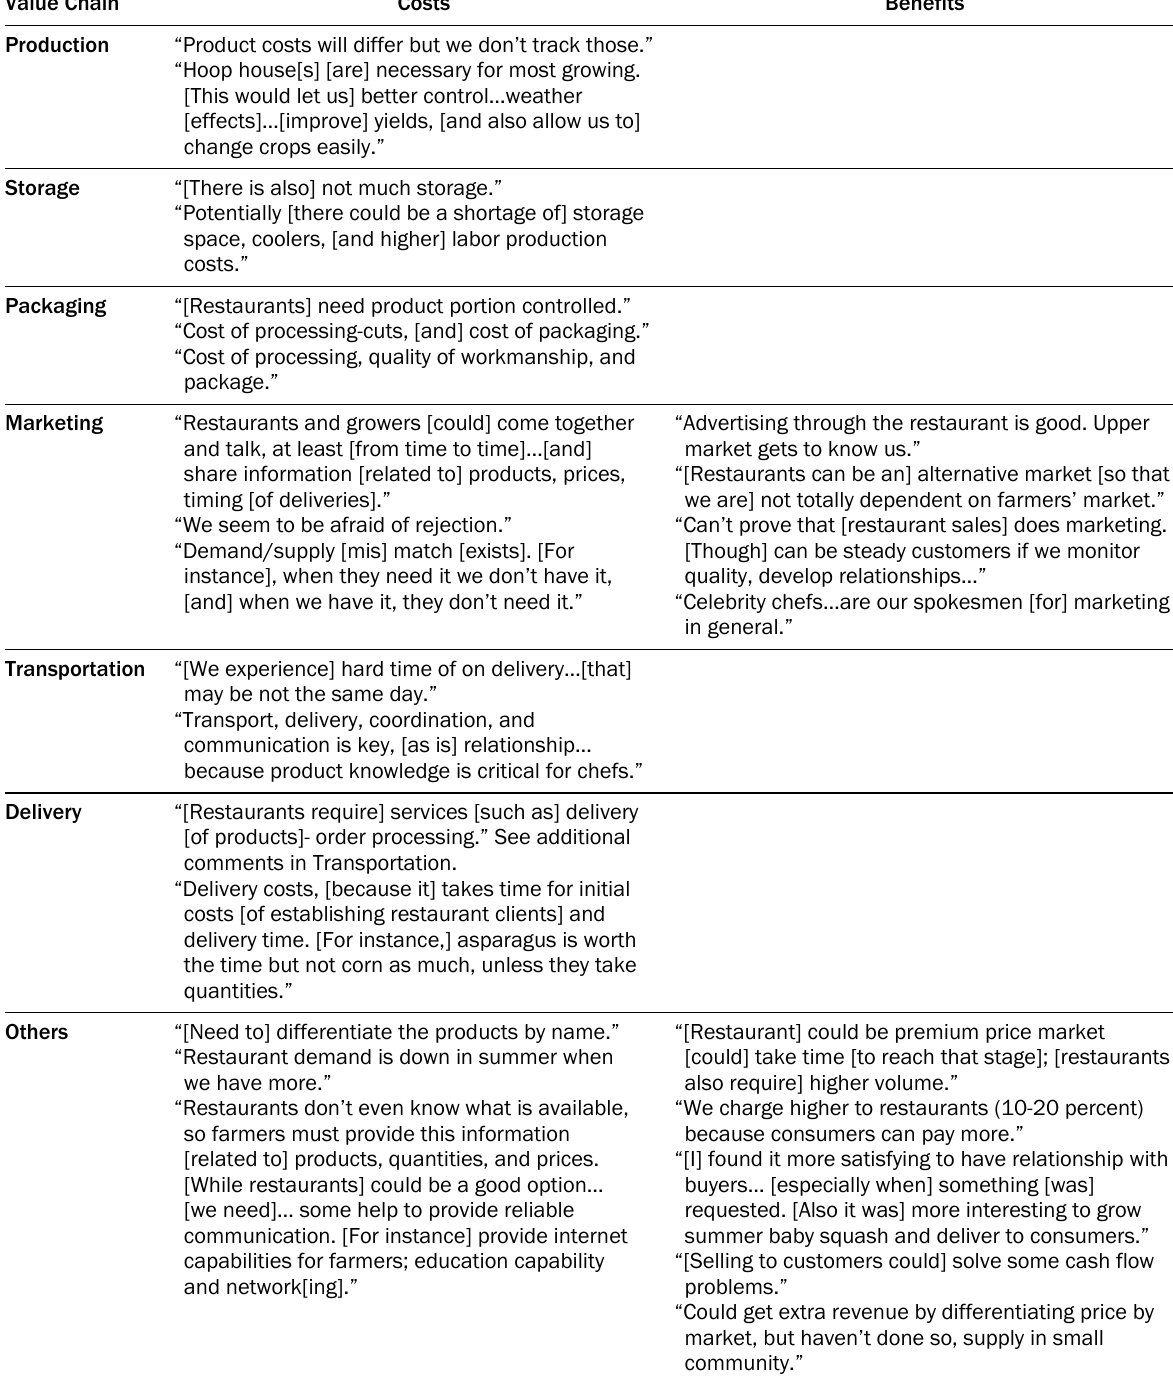
Table 1. Costs and Benefits of Local Food Value Chain to Restaurants: Respondent Quotes Value Chain Costs Benefits